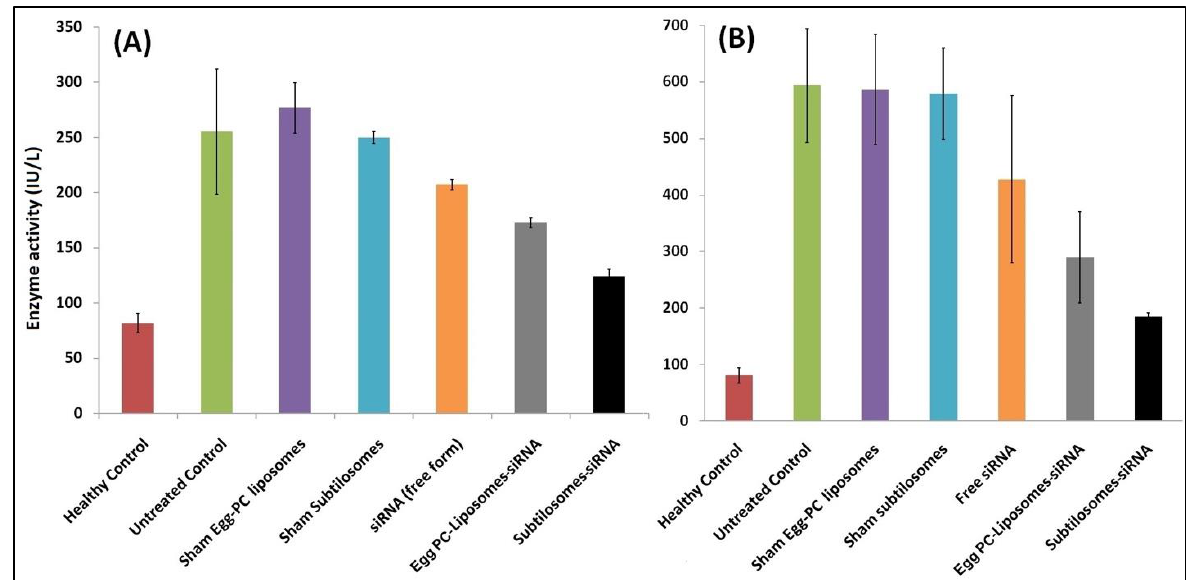
Figure 4. Liver-enzyme levels in animals treated with different siRNA-bearing liposomal formula- tions. Enzyme activities were measured as described in Materials and Methods. Data represented here are the means of three separate experiments ± SD. ( A ) ALT (subtilosome siRNA versus free siRNA p < 0.05, PC-liposome siRNA versus free siRNA p value not significant, subtilosome siRNA versus PC-liposome siRNA p < 0.05), ( B ) AST (subtilosome siRNA versus free siRNA p < 0.005, PC-liposome siRNA versus free siRNA p < 0.05, subtilosome siRNA versus PC-liposome siRNA p < 0.005).